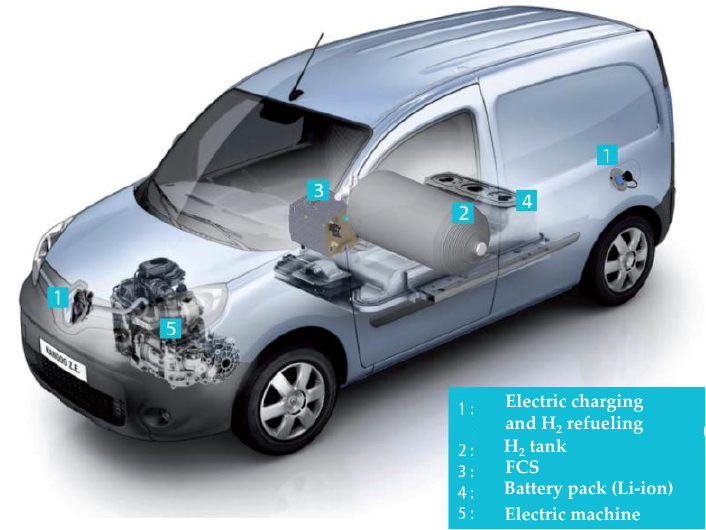
Figure 24. Range extender vehicle: Renault Kangoo ZE H2 Light Commercial Vehicle.